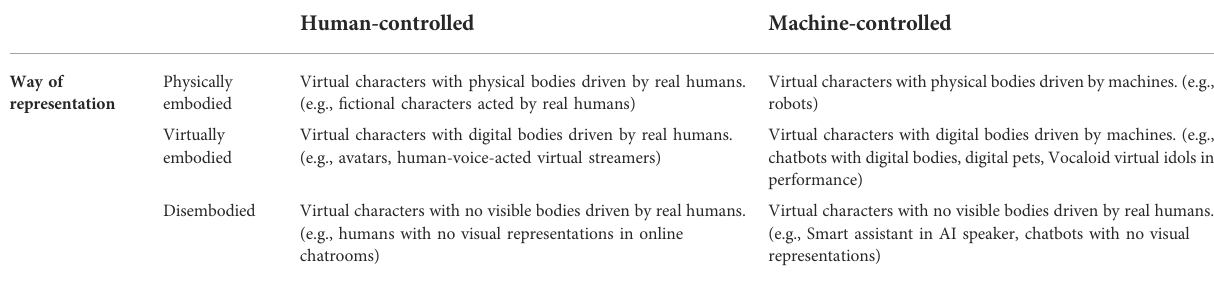
TABLE 1 A two-dimensional typology of virtual characters. Agency type Human-controlled Machine-controlled Way of